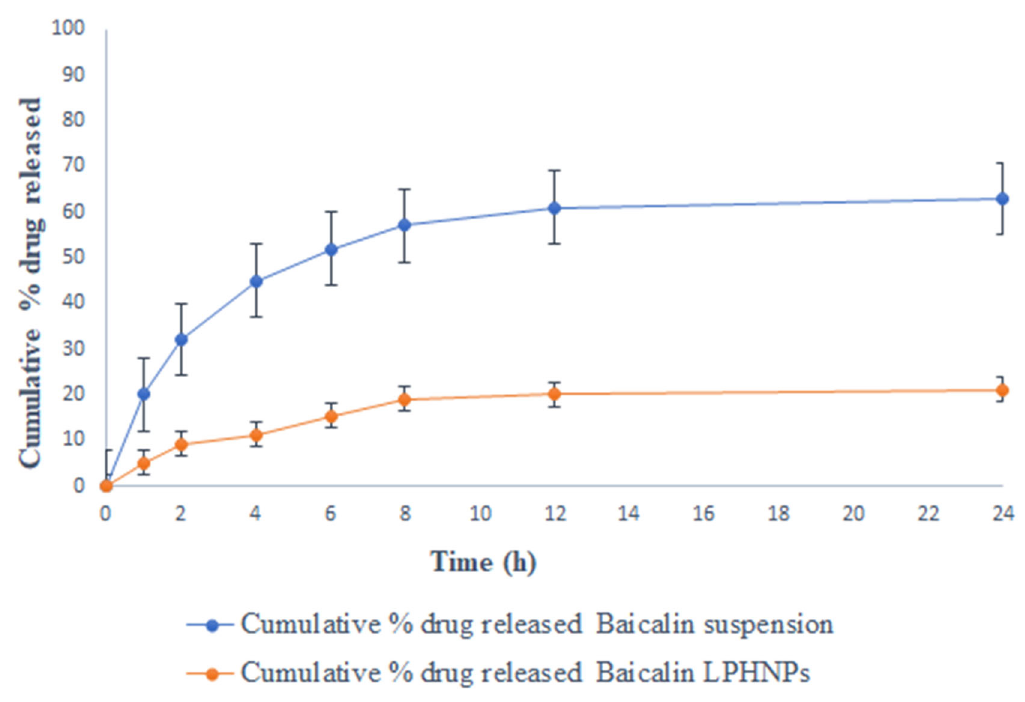
Figure 3. Percentage of in vitro release of baicalin ‐ loaded LPHNPs and baicalin suspension at pH 7.4. Data expresses as mean ± SD (n = 6).